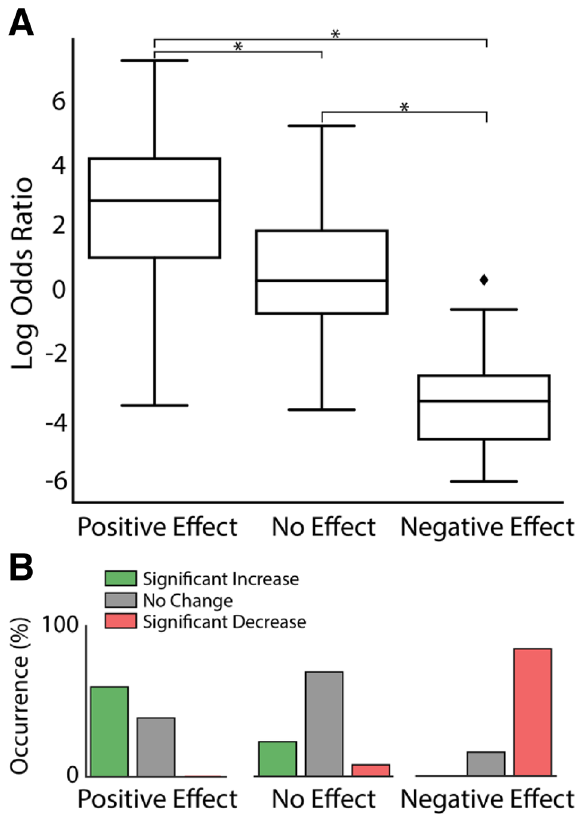
Figure 4. CT-DBS configuration-dependent effects on behavioral performance. ( A ) Stimulation configurations across the three animals are grouped by the configurations that had a positive effect on performance (left), no effect (middle), and a negative effect (right) and box plots showing the distribution of log odds ratio (LOR) changes. Each configuration group has significantly different effects on performance compared to the other two groups, with a two-tailed t-test and all p -values < 0.001. ( B ) The normalized occurrence of significant increases, significant decreases, and no significant change for the same three configurations groups determined by the significance of the LOR score at an α level of 0.05. Configurations in the positive effect group predominantly show significant increases in performance with no occurrence of significant decreases whereas configurations in the negative effect group predominantly show the